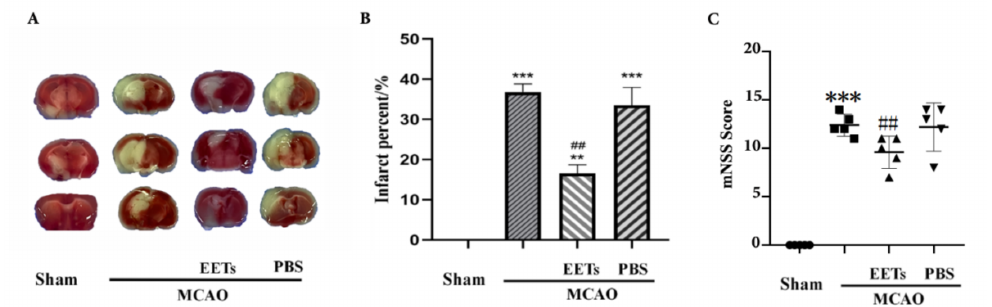
Figure 1. The cerebral infarct volumes were detected by TTC staining method after MCAO and reperfusion. ( A ) TTC staining was used in mouse brain tissue sections at 22 h after middle cerebral artery occlusion and reperfusion. The infarct area appears white. ( B ) Analysis of volume percentage of cerebral infarction ( n = 3). ( C ) The mNSS score of the mouse at 22 h after middle cerebral artery occlusion and reperfusion ( n = 5). (* * p <0.01, *** p <0.001 vs. sham; ## p <0.01 vs.